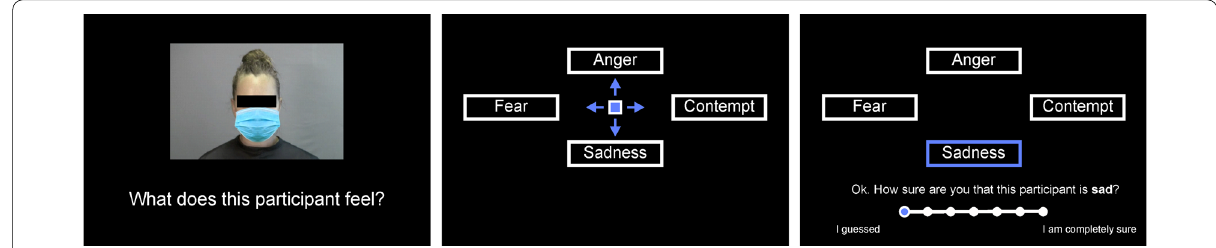
Fig. 1 Time line of an emotion recognition trial. Participants saw video clips (8 s) of 12 different young female models expressing fear, anger, contempt or sadness. For each participant the lower part of the face of half of the models was covered with a digitally added surgical face mask (left). After each video a response screen appeared, asking participants to select the emotion they thought the person in the video had experienced (middle) by button press. After they had entered their response, participants were asked to rate how sure they were that their judgement was correct (right). In the figure, original German terms and texts are translated to English. Note that the black bar covering the model’s eye region was not shown in the